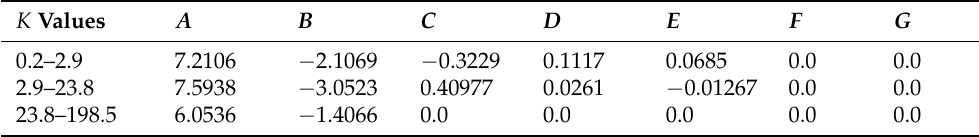
Table 4. Parameters for Equation (7) for peak incident overpressure (from Swisdak).